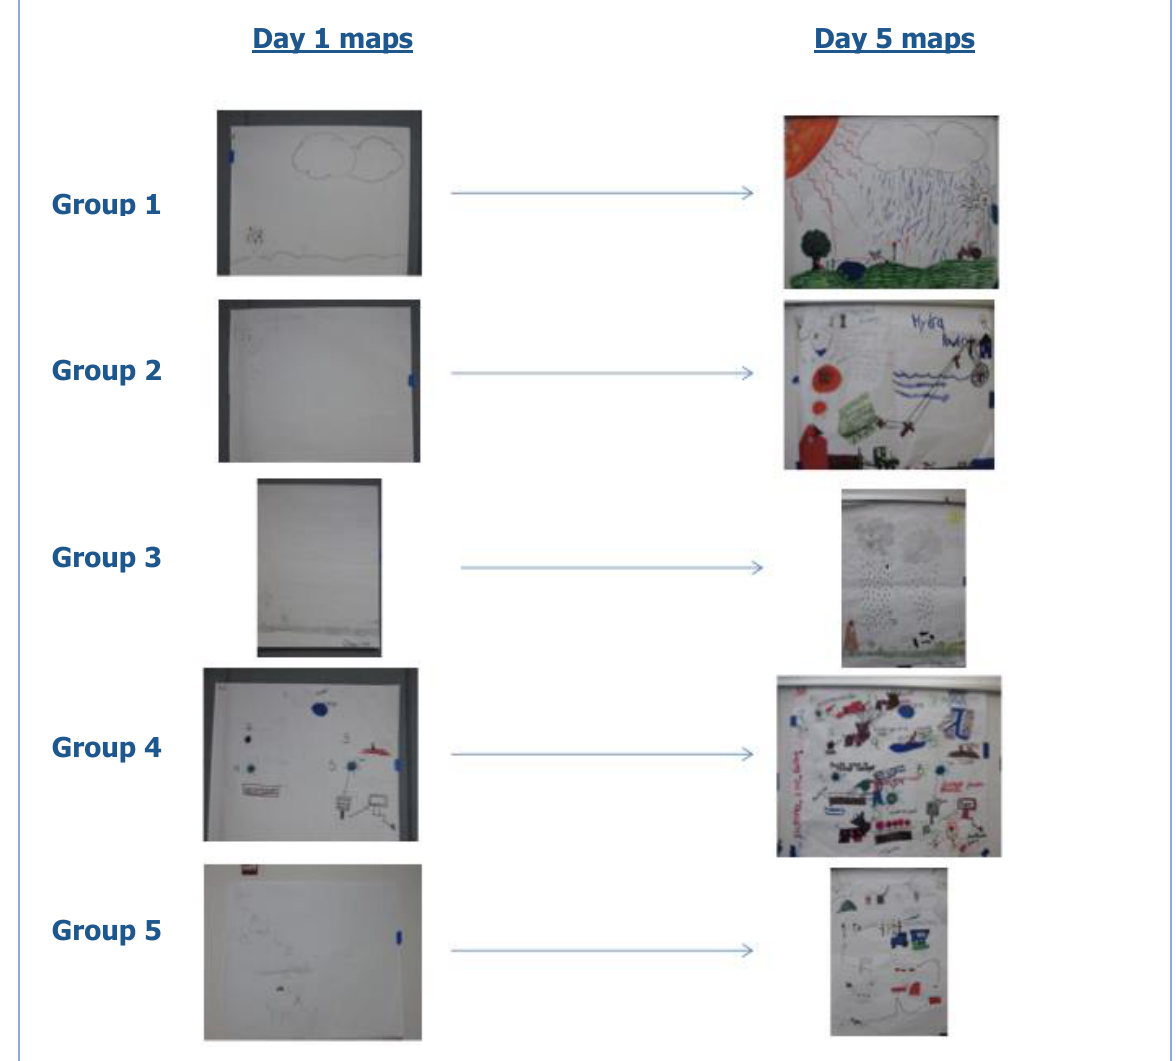
Figure 2. Visual Depiction of Changes in Students’ Understanding of Farm System Components Over Time Using Group